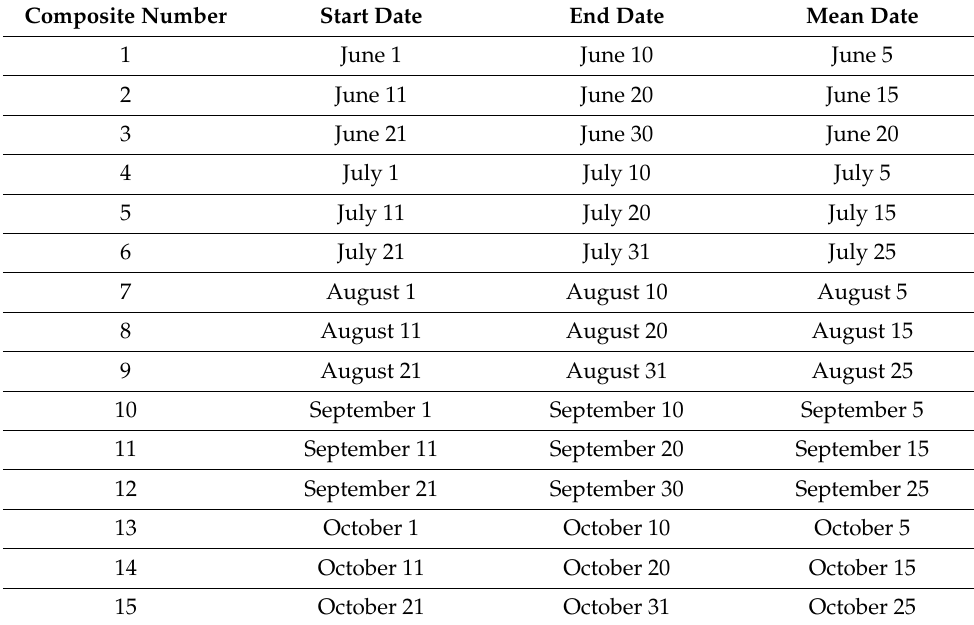
Table 1. The 10-day composite numbering system used for each